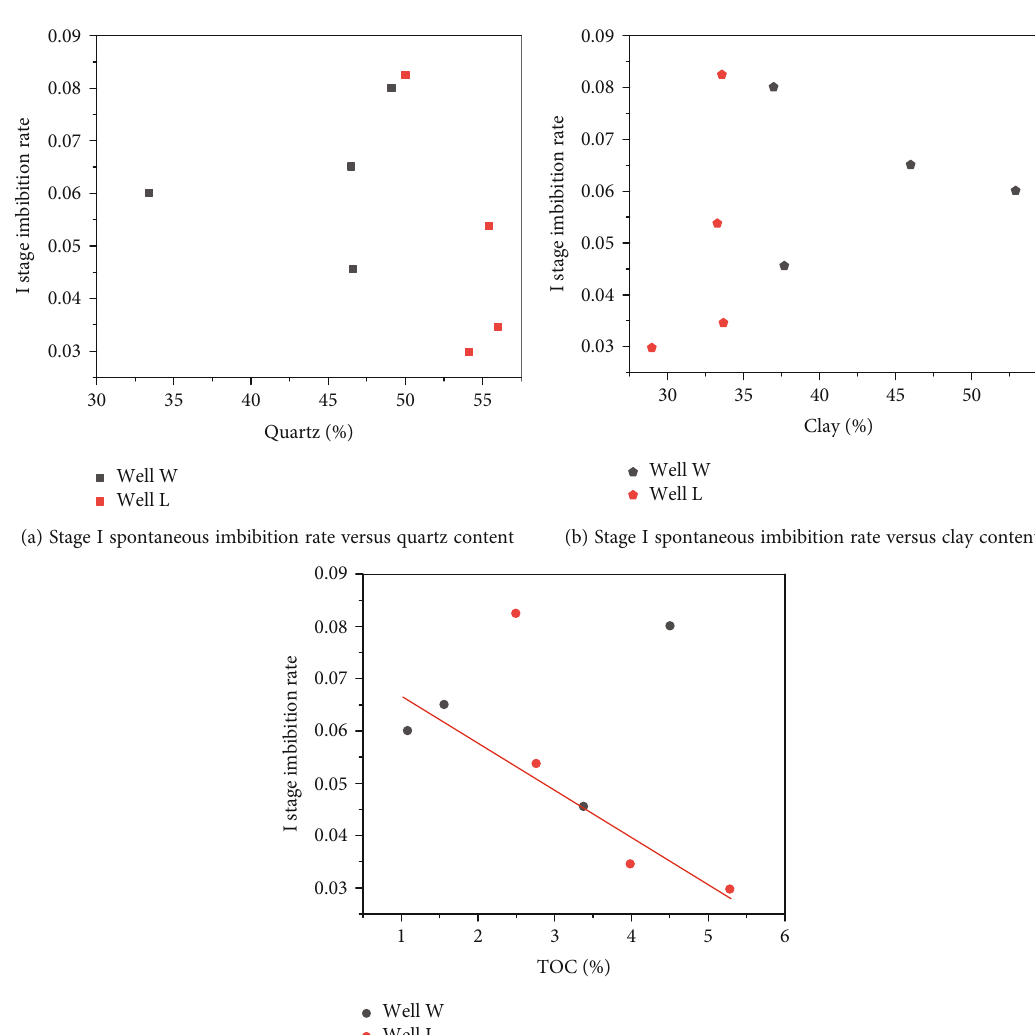
(c) Stage I spontaneous imbibition rate versus TOC content Figure 10: Relationship between spontaneous imbibition rate and mineral composition and TOC content of the deep